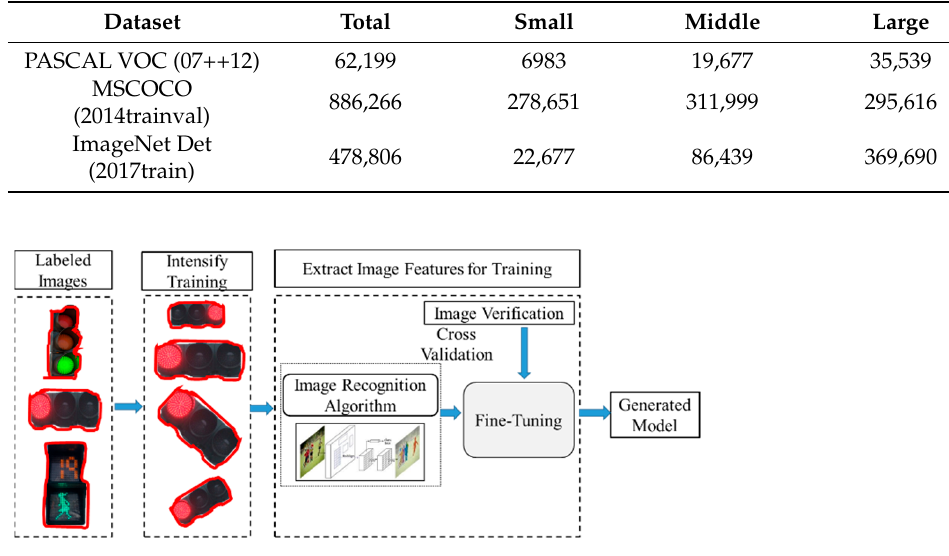
Figure 7. Flowchart of model training.